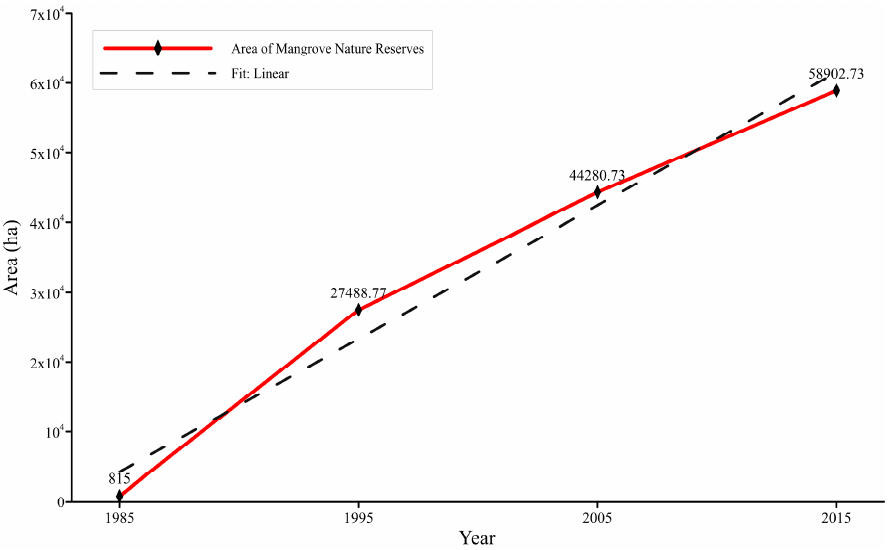
Figure 10. Total area of Mangrove Nature Reserves in Guangdong province from 1985 to 2015. Table 5. Details of Mangrove Nature Reserves in Guangdong